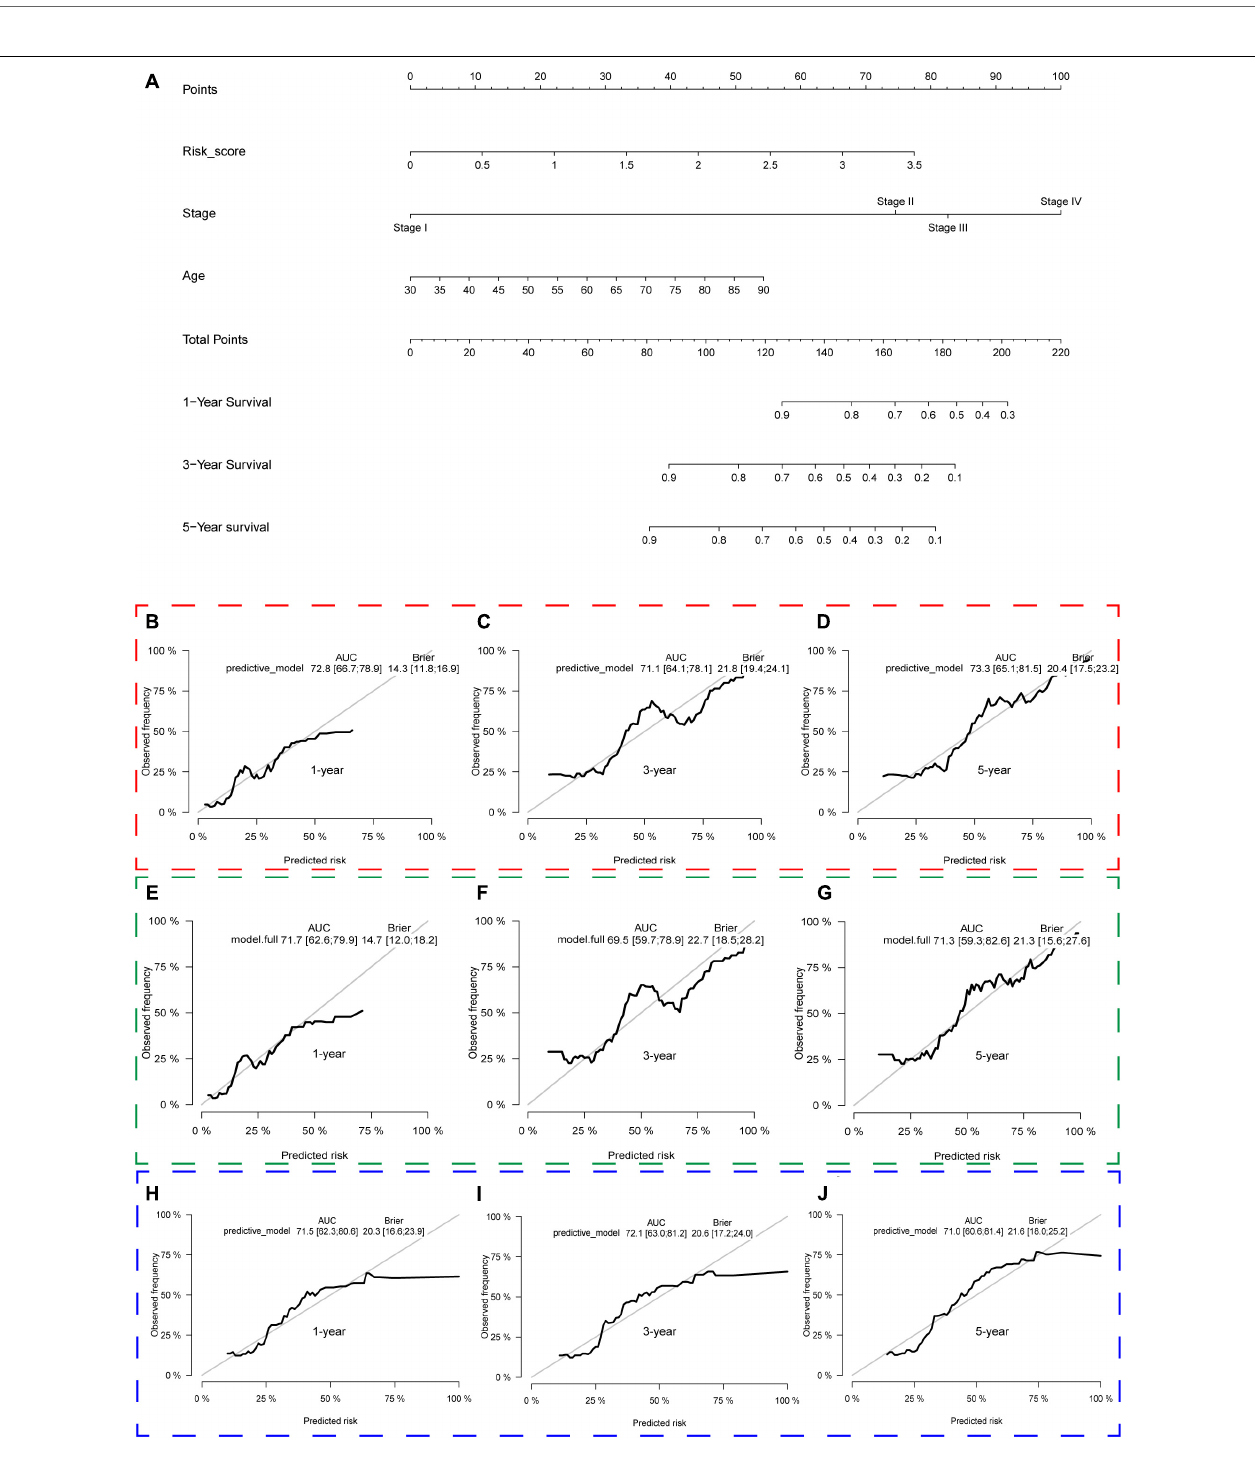
FIGURE 13 | The nomogram of the gene signature and its performance in the training set and internal and external validation sets. The predictive model was presented with a nomogram (A) . The red, green, and blue dashed boxes corresponded to the TCGA dataset, internal validation set, and GSE13507. The AUC and Brier scores of the nomogram in 1, 3, and 5 years in the training set (B–D) , internal validation set (E–G) , and GSE13507 (H–J) .